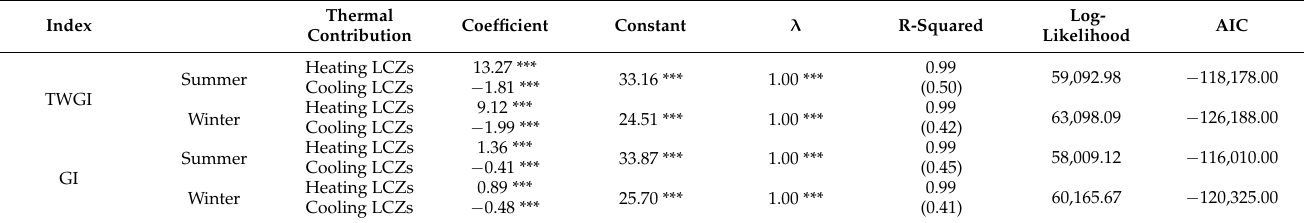
Table A4. Comparison of the results of SEMs based on GI and TWGI in Jinghong (*** p < 0.001, R-squared values of OLS are presented in